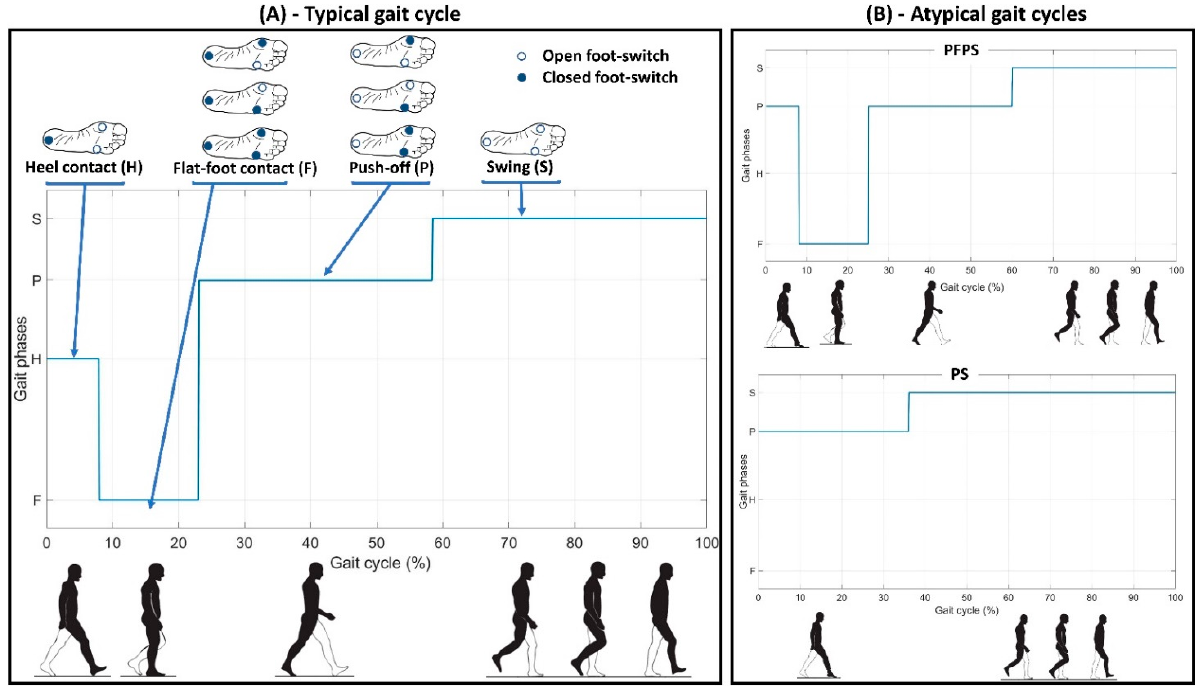
Figure 3. Example of 4-level foot-switch signals and gait cycle phases (H: Heel Contact, F: Flat-Foot Contact, P: Push-Off, and S: Swing) acquired from the right foot (more affected side) of a representative PD patient. Panel ( A ) represents an example of a typical gait cycle, while panel ( B ) shows two examples of atypical gait cycles (PFPS and PS).